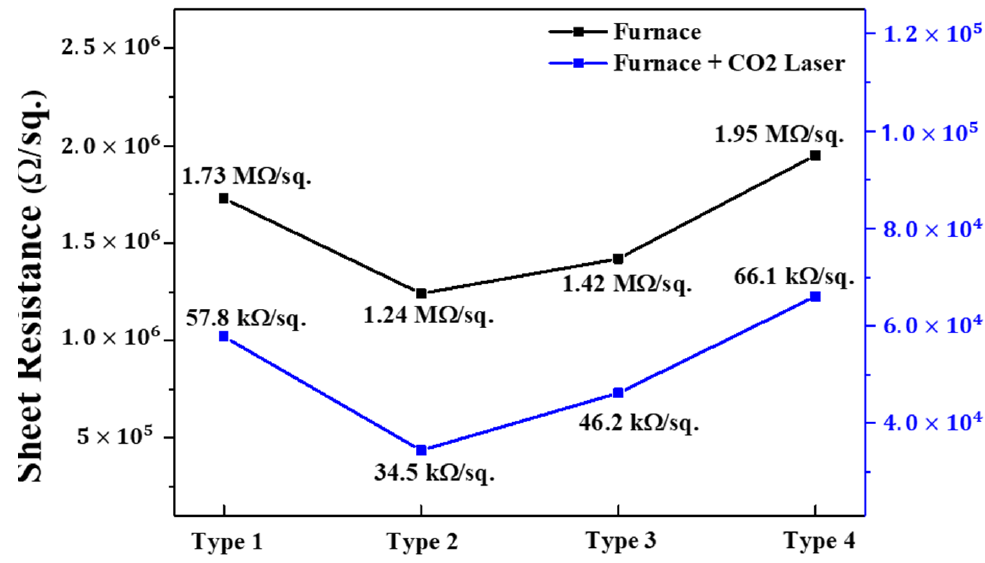
Figure 5. Sheet resistance of 4 types of (In, Ga) co-doped ZnO multilayered thin films after electrical furnace and furnace & CO 2 laser annealing.